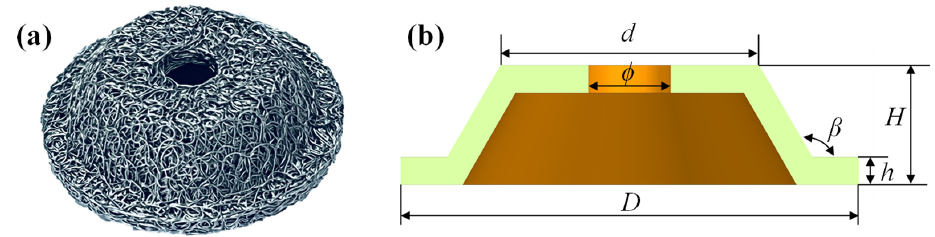
Table 2. Chemical composition of the 06Cr19Ni10 material.